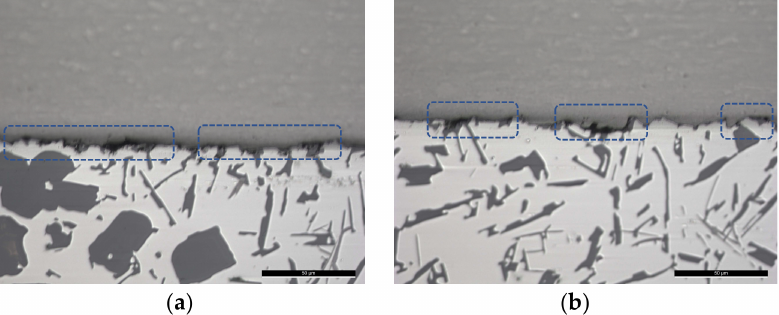
Figure 14. Light microscope images of (13/585L) brazed joint using Al-13Si filler alloy at 585 ◦ C with initial load only, “No USV”; close to the joint edge where ( a ) is closer than ( b ). The scale is 50 µ m on the images.